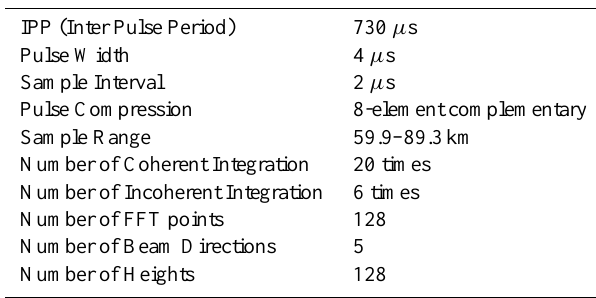
Table 1. Observational parameters of the mesosphere mode